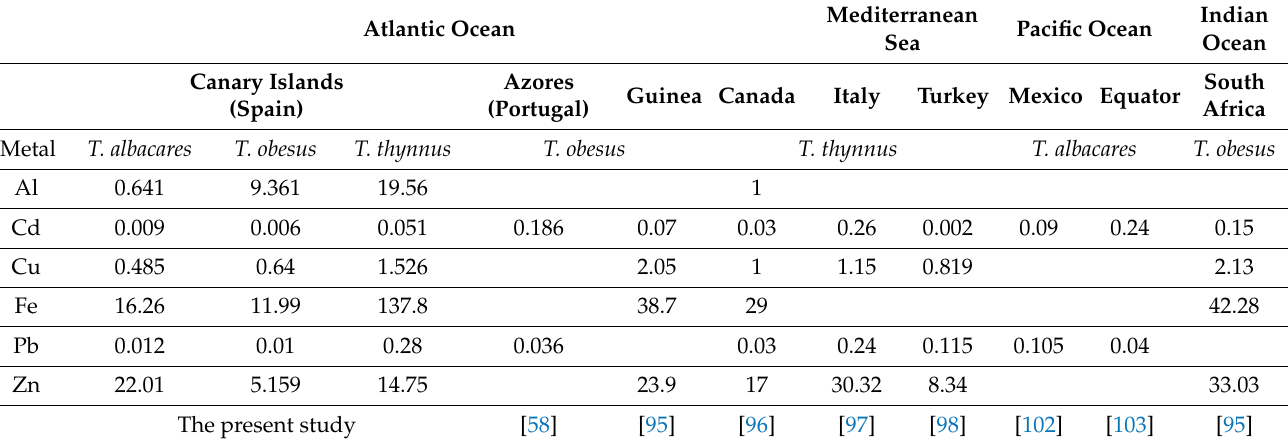
Table 5. Metal comparison of the species T. albacares , T. obesus and T. thynnus with other studies in mg/kg. Atlantic